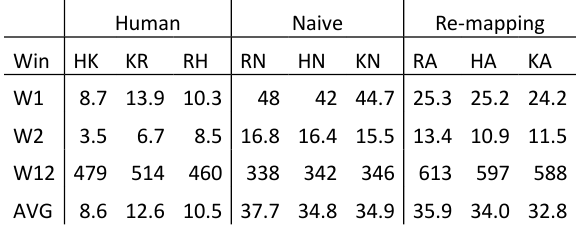
Tabel 2 Average character distance between two fixa- tion-to-symbol mappings for source window (W1) target win- dow (W2),in case the fixations are mapped in different windows (W12) and the average character distance (AVG).